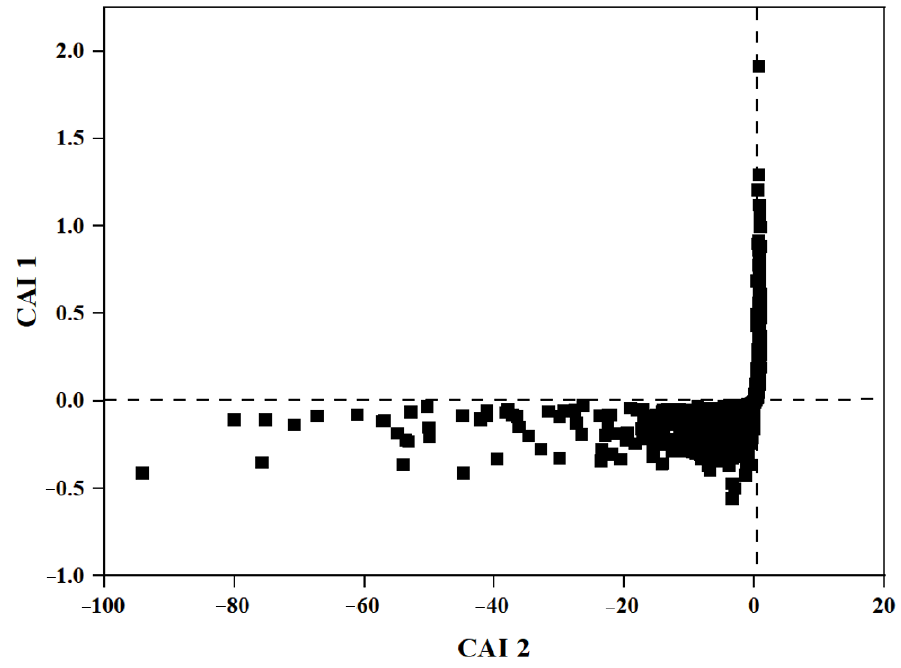
Figure 5. Relationship between CAI 1 and CAI 2.